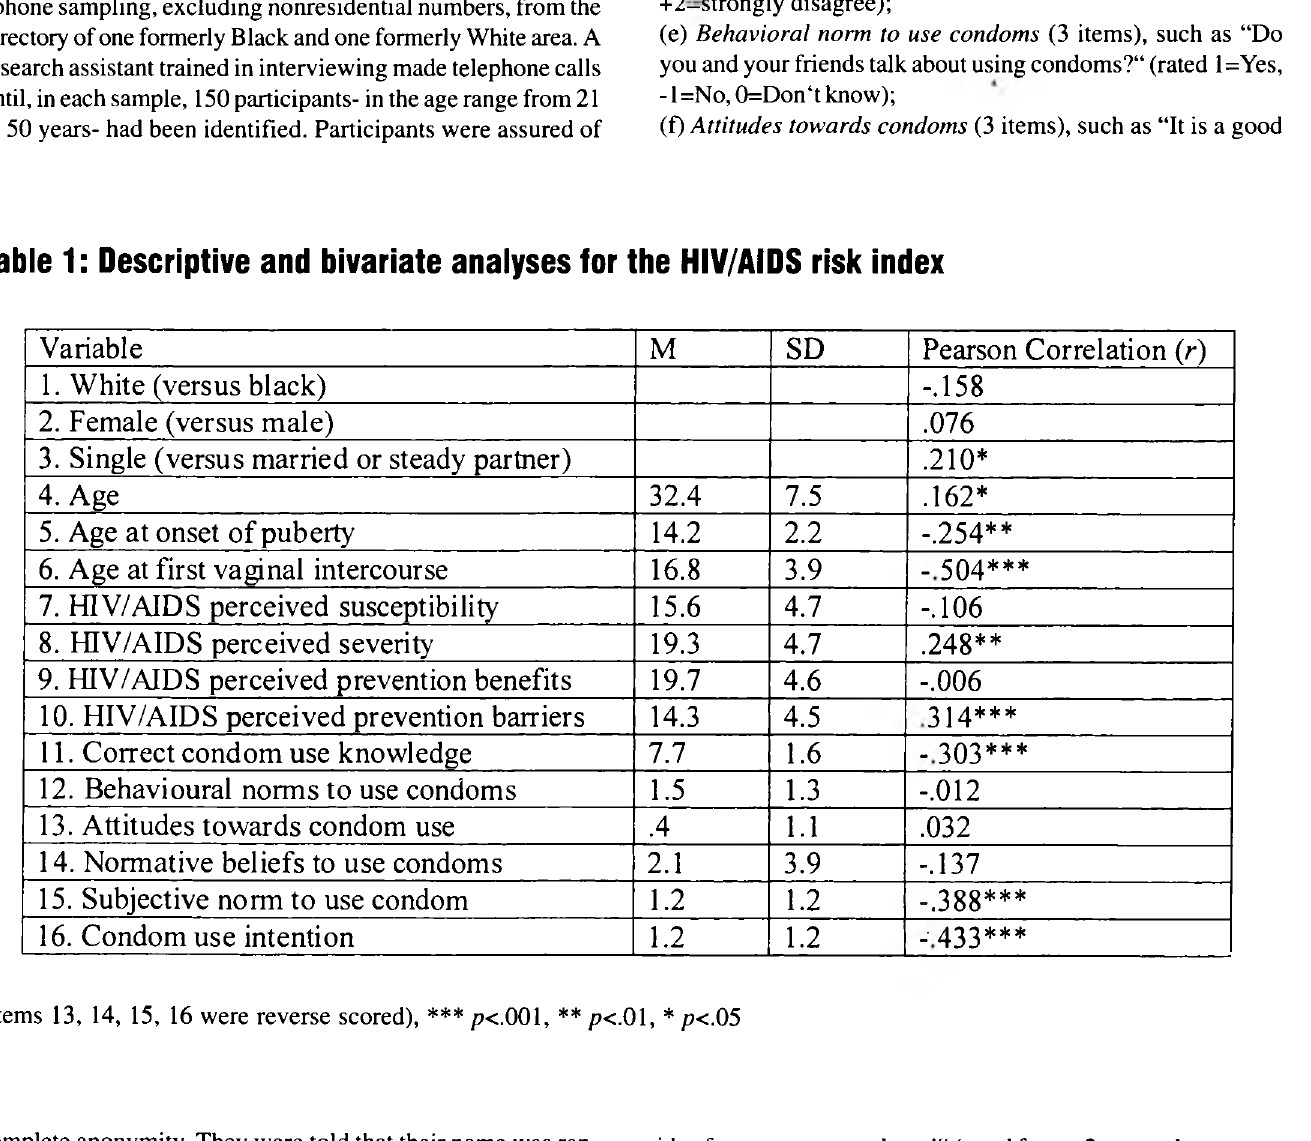
Table 1 : Descriptive and bivariate analyses for the HIV/AIDS risk index